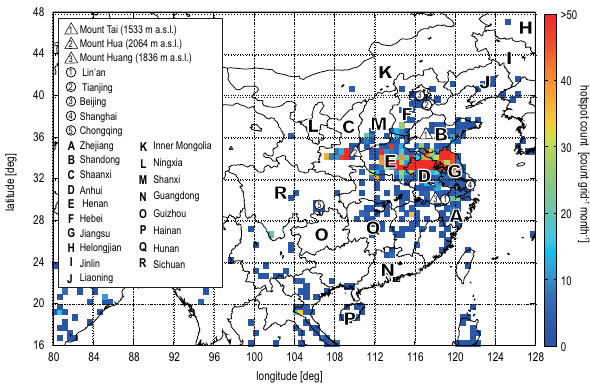
Fig. 2. Map of China with fire counts in June 2006.